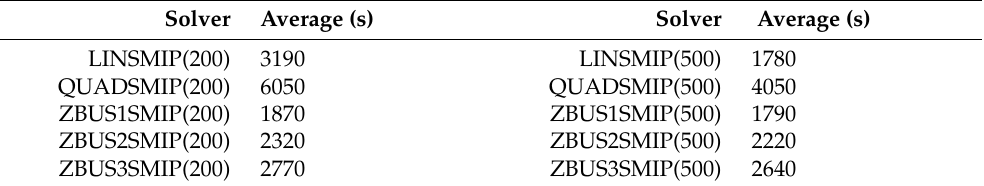
Table 4. Comparison of solve times for SMIP methods with different initial point separation dis- tances, P ∆ .